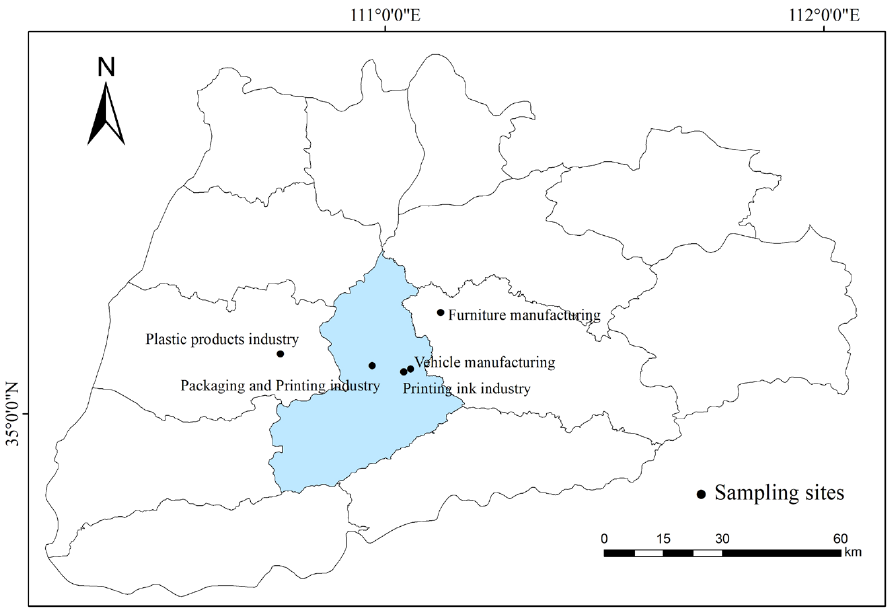
Figure 1. Sampling point area bitmap.